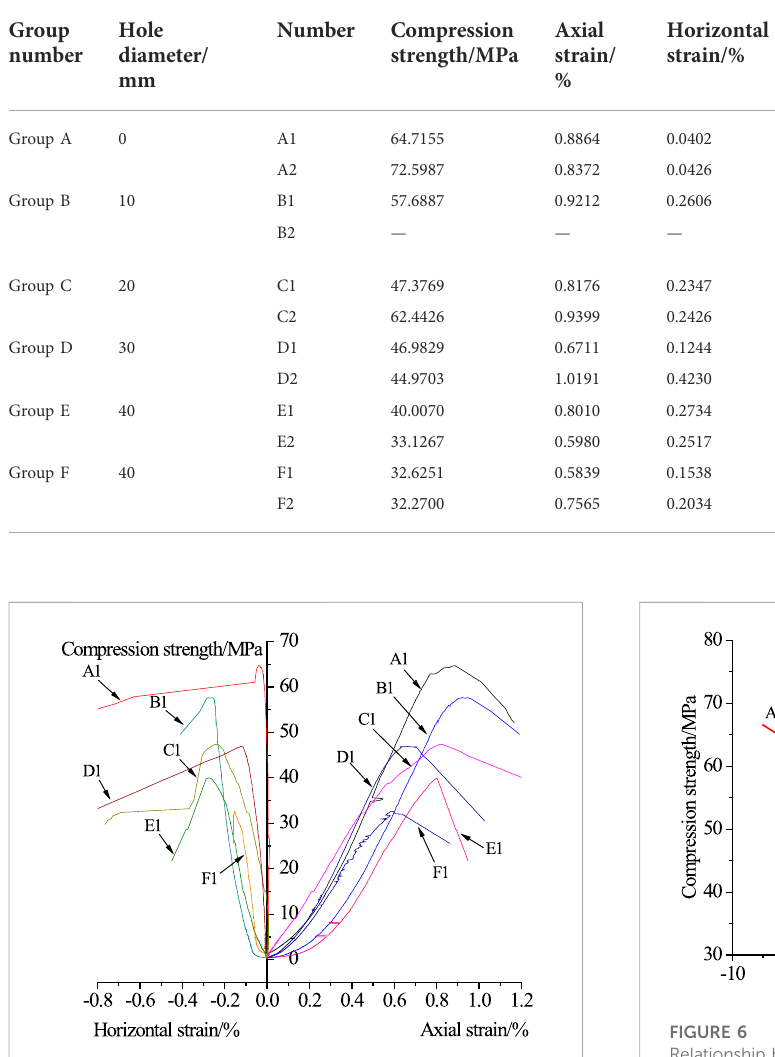
FIGURE 6 Relationship between the hole diameter and compression